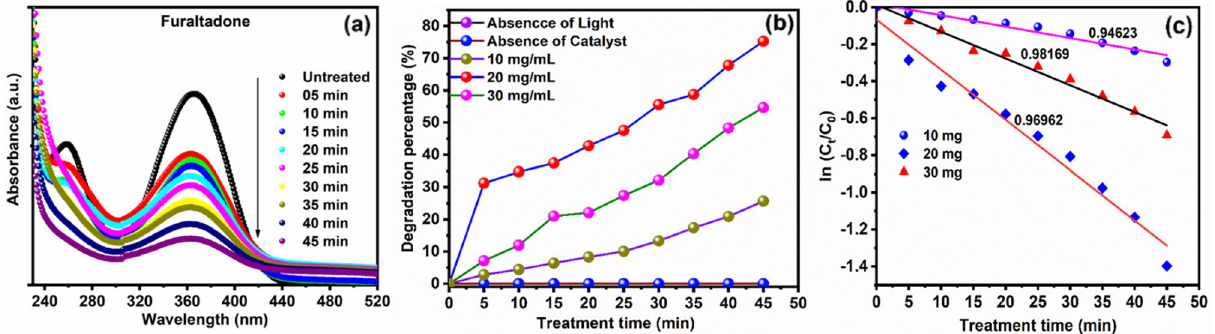
Figure 12. The synthesized Cu/Ni/TiO 2 /MWCNTs nanocomposites photocatalytic activities using FLT ( a ) Absorbance spectrum of FLT before and after the treatment process, ( b ) Degradation percentage of FLT with various concentration function of treatment time ( c ) FLT degradation first-order kinetic